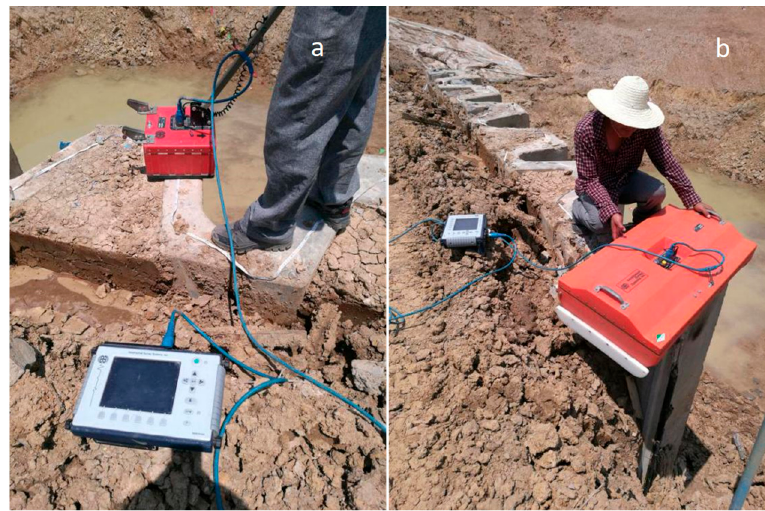
Figure 4. SIR-3000 GPR system field detection: ( a ) 400 MHz, ( b ) 100 Table 1. Parameter settings for field data collection.